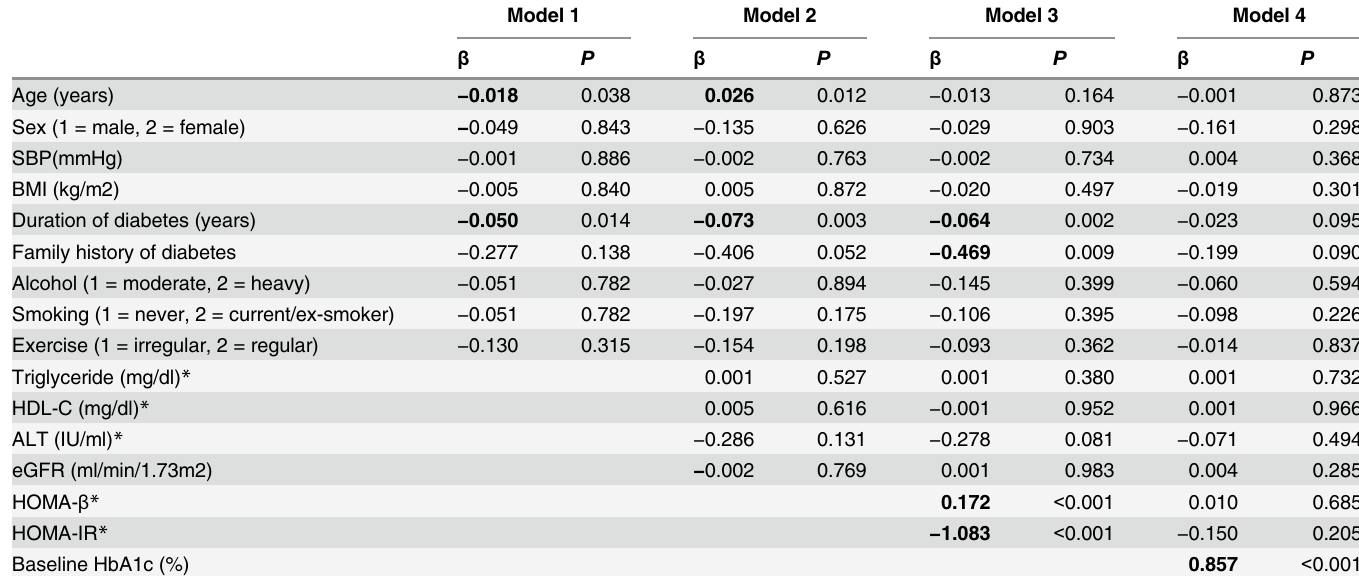
Table 2. The predictive factors for long-term HbA 1c reduction of initial combination therapy with sitagliptin and metformin. Model